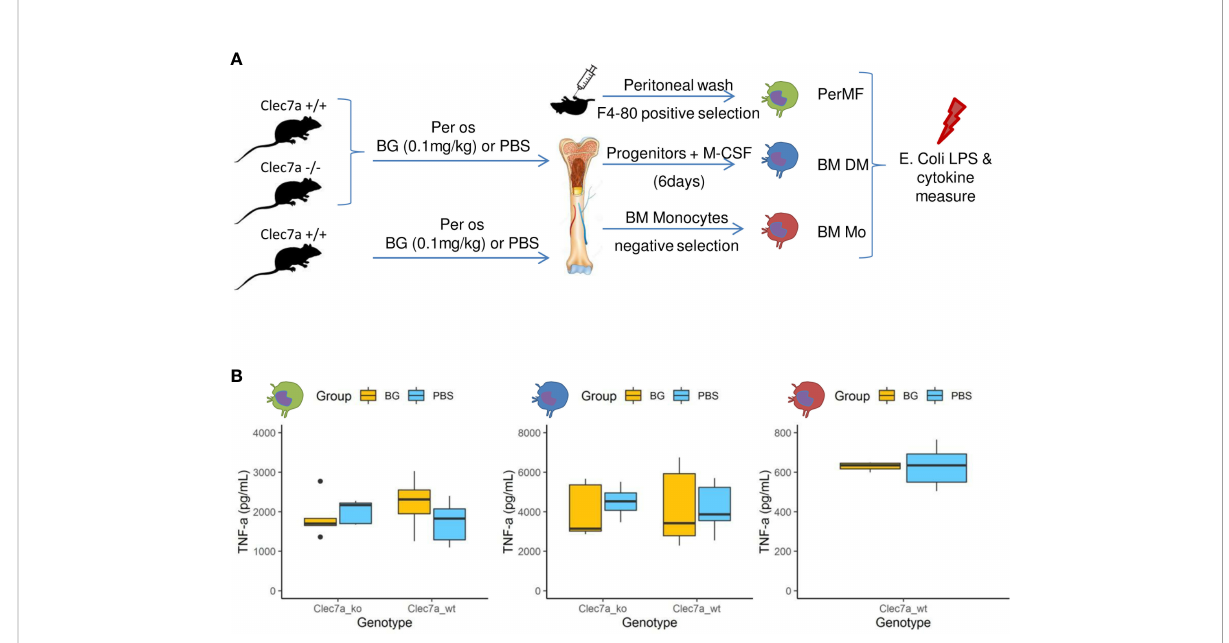
FIGURE 7 Cytokine secretion by macrophages or monocytes isolated or generated from b -glucan- or PBS-supplemented mice at steady state. (A) Experimental design. (B) TNF a (pg/mL) secretion in culture supernatants of (green) resident peritoneal macrophages, (blue) bone marrow- derived macrophages, or (red) bone-marrow monocytes stimulated for 24 h with E . coli LPS. Statistical analysis was performed using the Welch t-test and signi fi cant p values are indicated. For PerMF and BMDM, the data were collected from two individual experiments representing a total of eight wildtype and fi ve clec7a -/- b -glucan - supplemented mice and 10 wildtype and fi ve clec7a -/- PBS-supplemented mice. For monocytes isolated from bone marrow, the data were collected from a single experiment with a total of six wildtype b -glucan- and six PBS-supplemented mice pooled two by two to reach suf fi cient monocyte